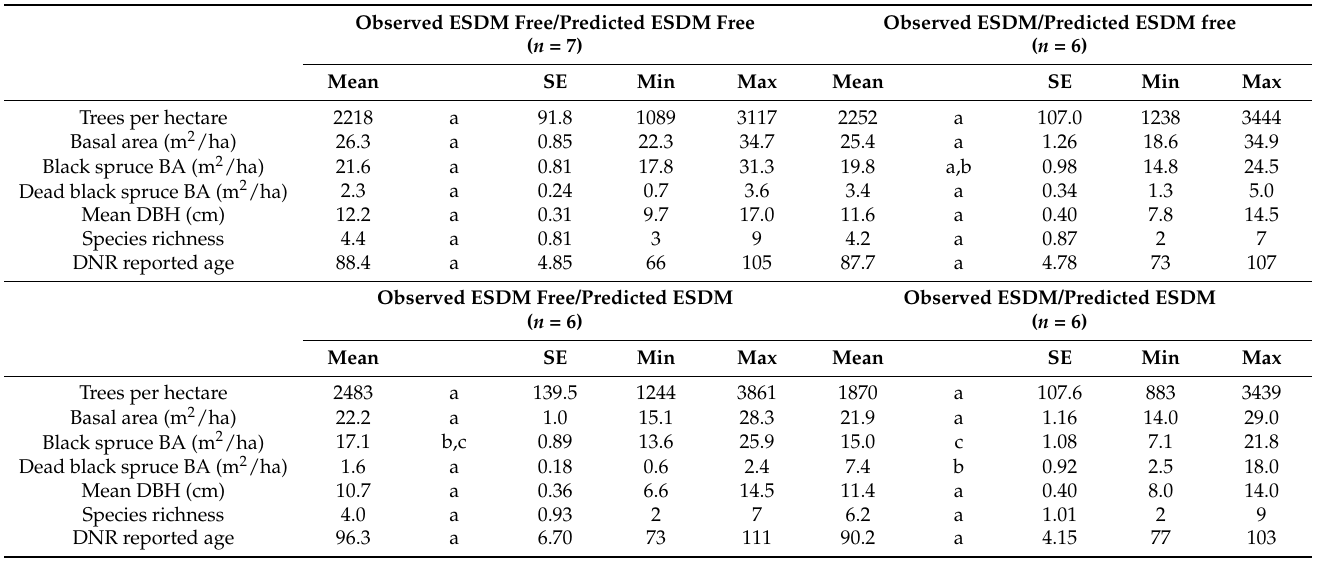
Table 3. Stand structure characteristics of the 25 sampled stands with or without eastern spruce dwarf mistletoe (ESDM), calculated from field surveys, and classified as true negative, false negative, false positive, and true positive. Unless otherwise specified, all values reflect those of living trees only. Means followed by the same letter are not significantly different by Tukey’s HSD test at a 0.05 level of significance for predictive